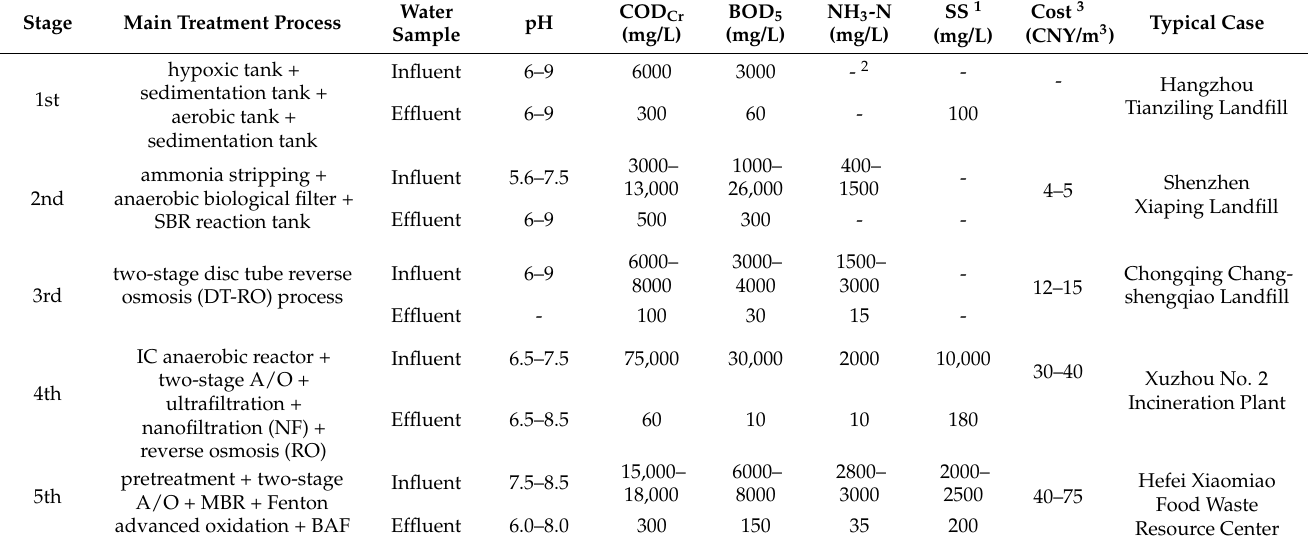
Table 6. Influent and effluent characteristics of leachate treatment from municipal solid waste treatment and disposal plants at different development